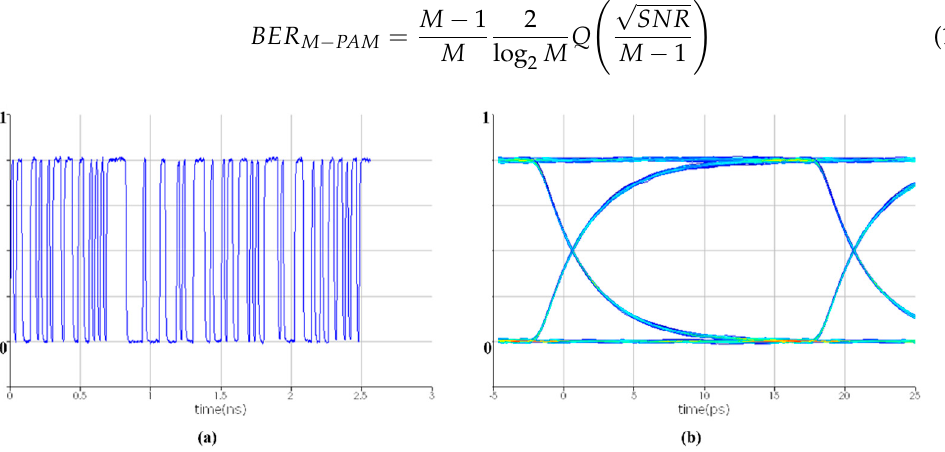
Figure 9. The ( a ) V-t diagram and ( b ) eye diagram of a pseudo-random binary sequence (PRBS) OOK signal.